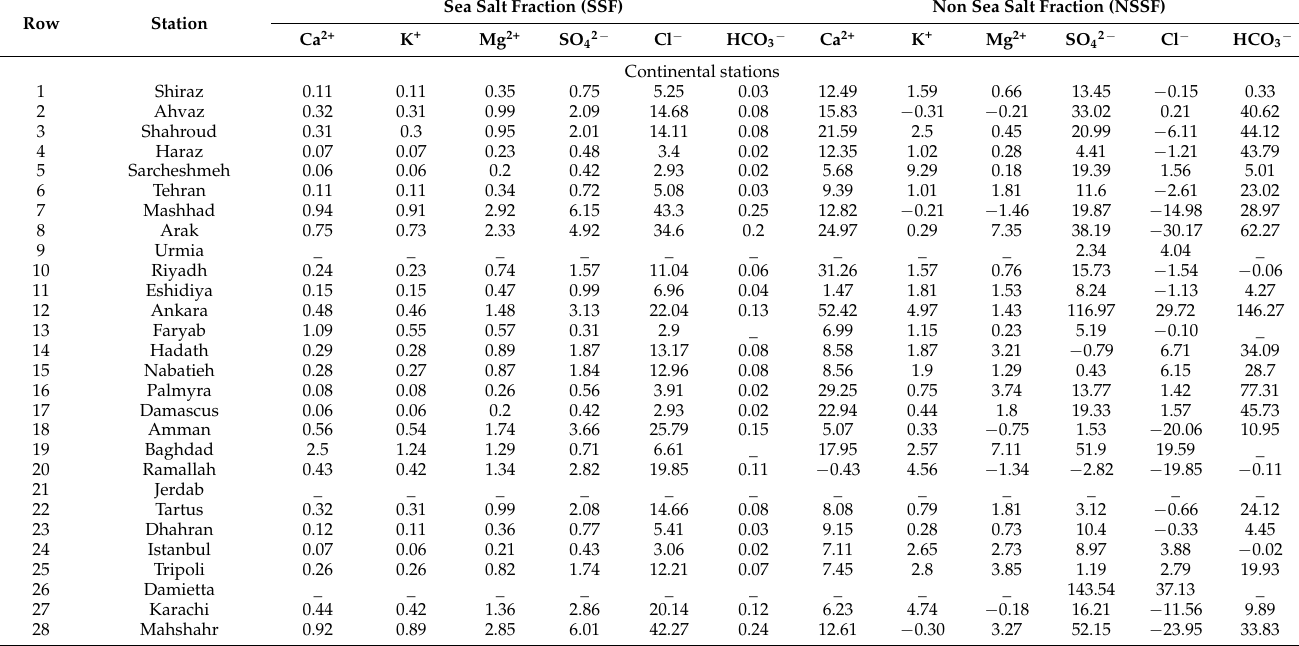
Table 1. The SSF and NSSF of the major ions in the Middle East precipitation.